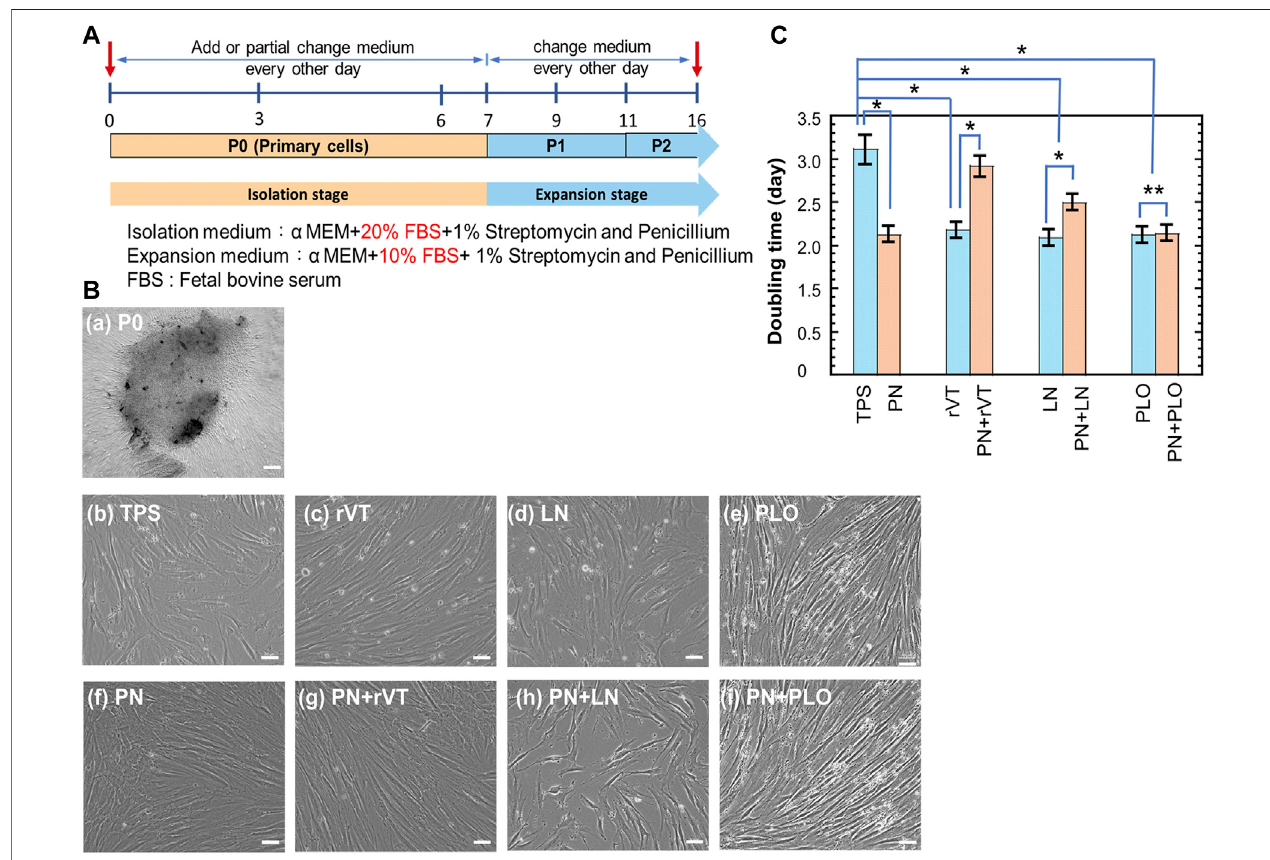
FIGURE 3 | Cultivation of DPSCs on TPS, TPS-PN, TPS-ECM, TPS-PLO, TPS-PN-ECM and TPS-PN-PLO plates for fi ve passages. (A) The timeline of primary DPSCs culturing and expansion. (B) The morphologies of primary DPSCs (day 5 at P0) (a) and day 5 at P5 (b – i) on the TPS (b) , TPS-rVT (c) , TPS-LN (d) , TPS-PLO (e) , TPS-PN (f) , TPS-PN-rVT (g) , TPS-PN-LN (h) and TPS-PN-PLO (i) plates. (C) The doubling time of DPSCs on TPS, TPS-PN, TPS-ECM, TPS-PLO, TPS-PN-ECM and TPS-PN-PLO plates at passages 3-5. The bar indicates 200 μ m (a) and 50 μ m (b – i) . * p < 0.05. ** p >